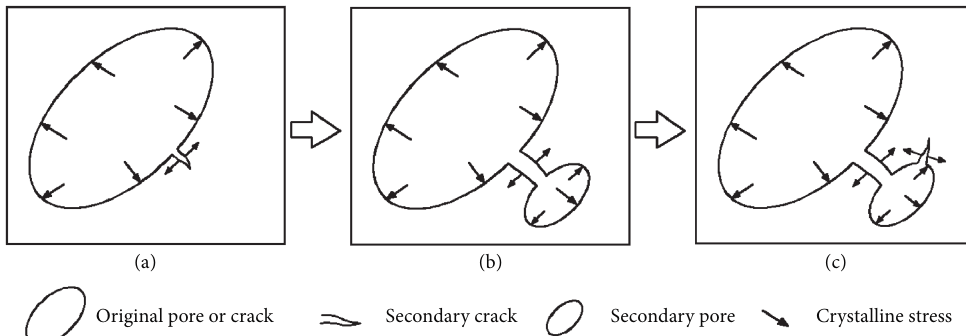
Figure 15: Microscopic process of the salt-rock dry-wet cycle. (a) Pore unit. (b) Crystallization that produced secondary pores or cracks. (c) More pores or cracks